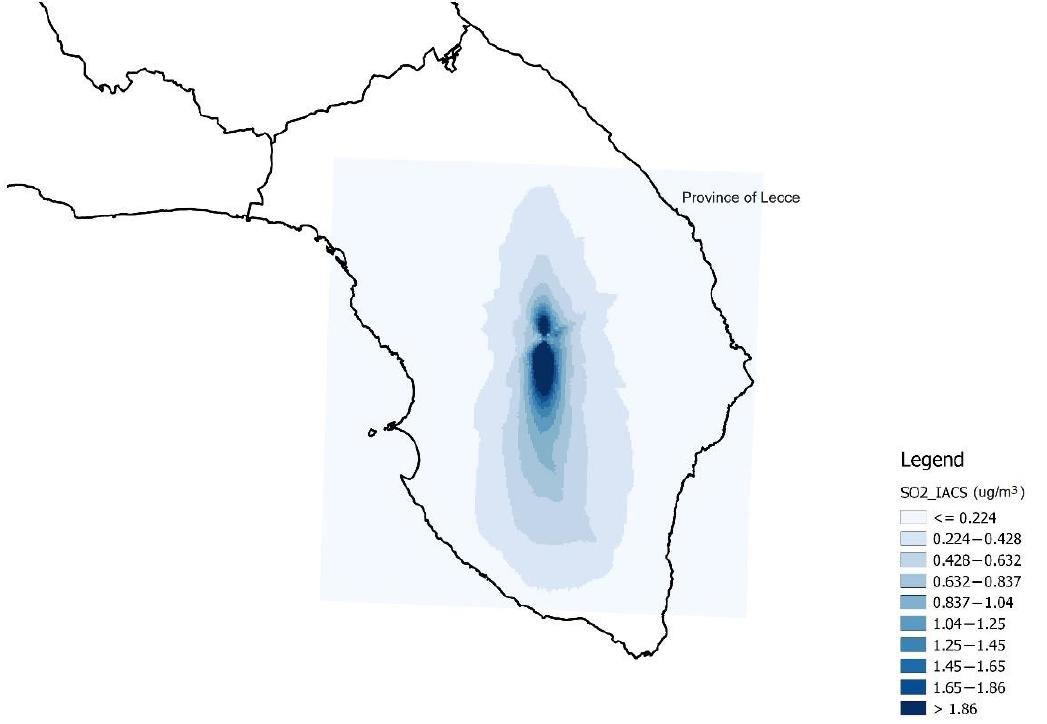
Figure 1. Spatial distribution of sulfur dioxide concentrations emitted by the plants included in Industrial Area of Central Salento (IACS) (SO 2 _IACS) (data in µg/m 3 from 1990).